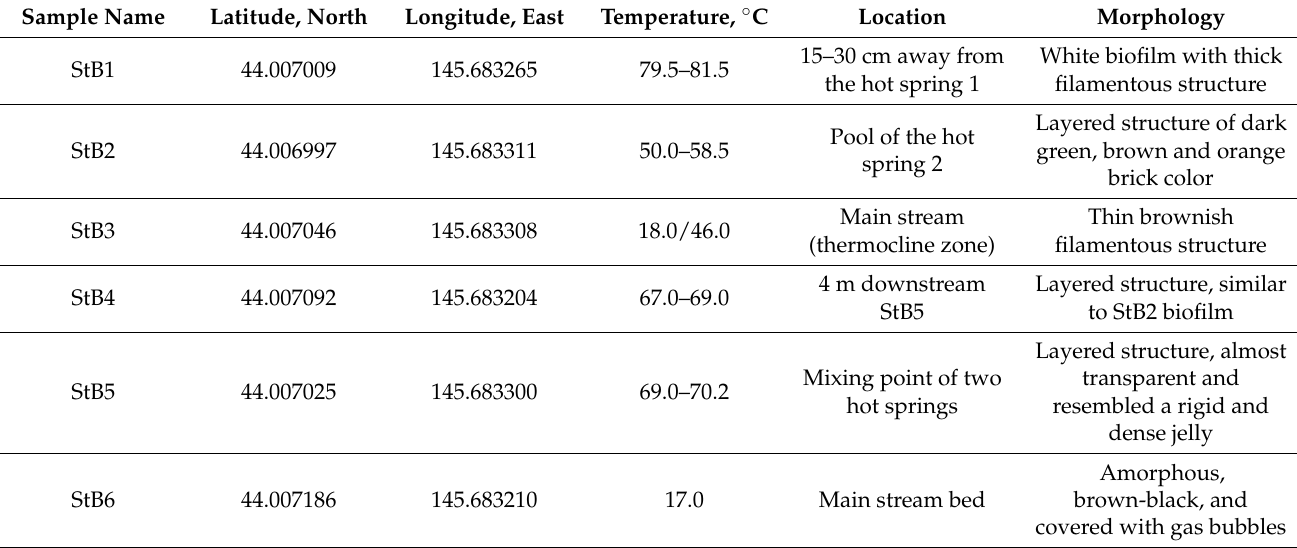
Table 1. The characteristic of the sampling sites and description of the biofilms’ morphology. The water temperatures are presented in a